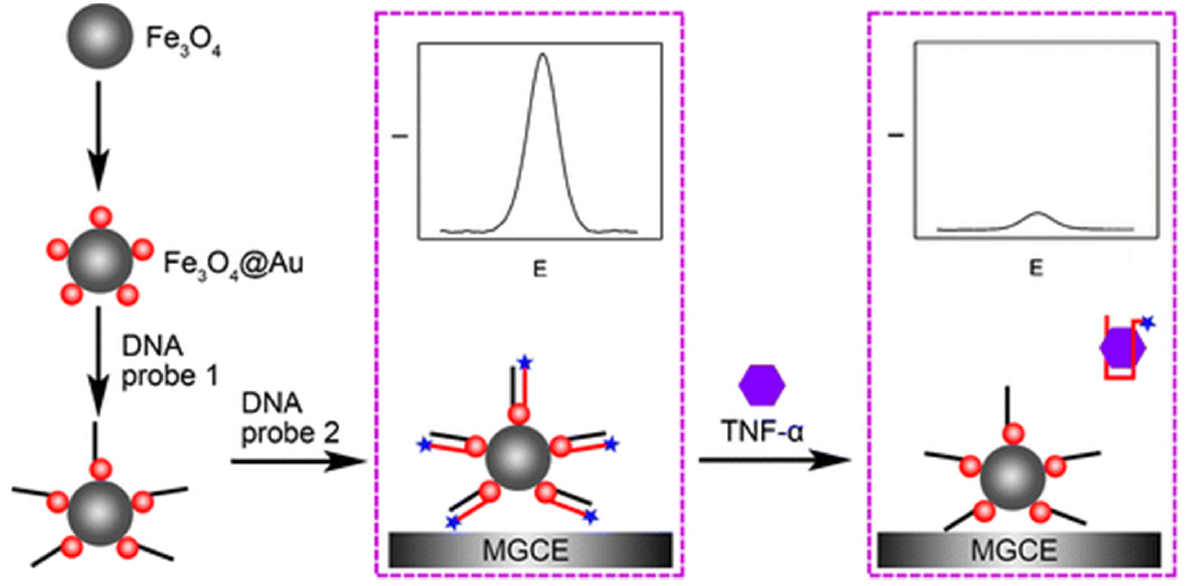
Figure 2. Fe 3 O 4 @AuNP assisted aptamer-based electrochemical method for the determination of TNF- α . Reproduced from [38] with permission.